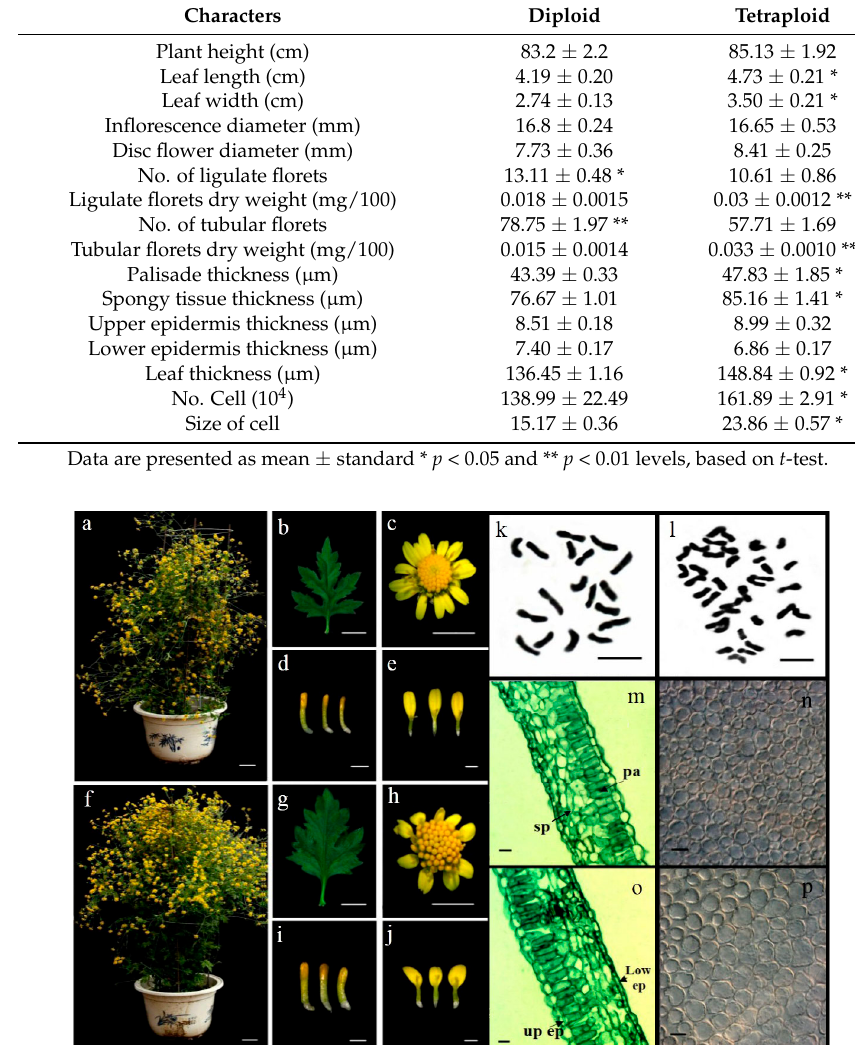
Table 1. Morphology of diploid and tetraploid Chrysanthemum lavandulifolium .